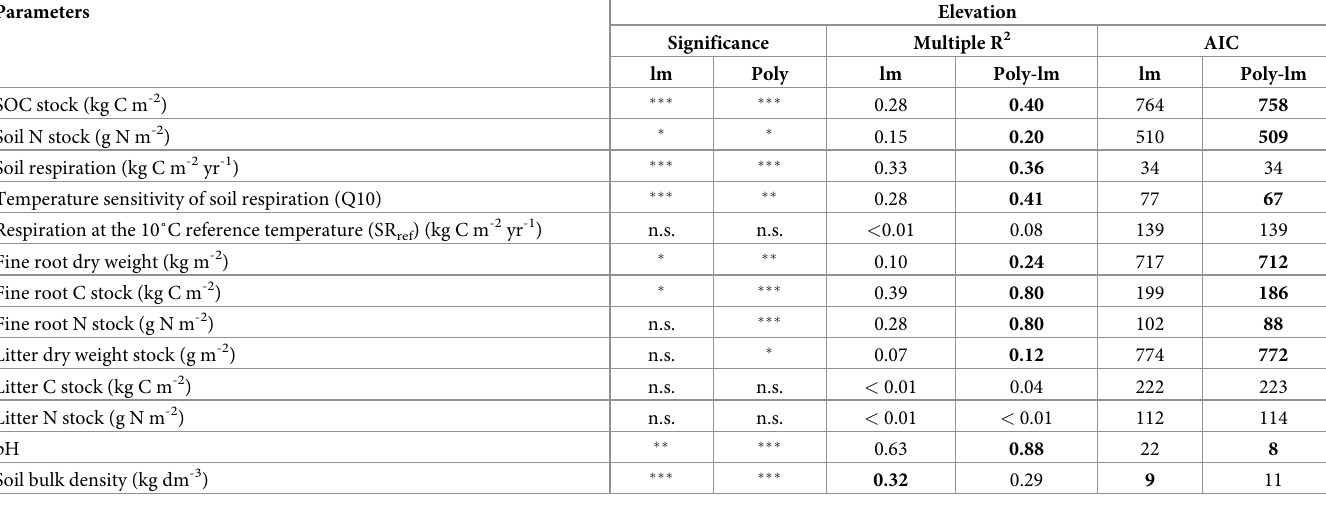
(Fig 2I): the lowest soil pH was measured in site B (pH 3.8 ± 0.1) and the highest in site E (pH 5.9 ± 0.2, Fig 2I). The highest bulk density was found in site D (1.01 ± 0.27 g cm -3 , Fig 2J) and the lowest was found in site B (0.26 ± 0.16 g cm -3 ; Fig 2J). Based on the AIC and R 2 , only soil bulk density was linearly related to elevation (Table 2). On the contrary, SOC and soil N stock, fine root dry weight, fine root C and N stock, pH and litter dry weight were better fitted with nonlinear relationships with elevation (Table 2; further detail about equation parameters can be found in S5 File). Furthermore, a significant correla- tion was found between SOC and soil N and soil pH, dominant tree height, stand age, basal area, and bulk density (Table 3). Soil respiration Both logistic and Q10 models confirmed that soil respiration rates increased with temperature in all sites (Fig 3), and the seasonal pattern of SR was similar to that of air chamber tempera- ture (S6 File). A strong linear relationship was found between observed and predicted SR (R 2 = 0.73; S7 File). Temperature explained between 55% and 76% of the variance in soil respiration at the experimental sites (Table 4). The Q10 and SR values obtained for the different sites ranged ref between 1.75 and 2.96, and between 2.17 and 4.49 ( μ mol CO m –2 s –1 ), respectively (Table 4). 2 The Q10 value recorded in site A (highest elevation) was significantly different from that of the other sites (Table 4). A significant linear relationship was identified between Q10 and ele- vation (Table 2). However, the trend between Q10 and temperature was best described by a nonlinear relationship (Table 2). Furthermore, a significant negative correlation was found between Q10 and mean dominant tree height and basal area (Table 3). No significant relation- ship between SR and elevation was found (Table 2). However, significant differences were ref found between experimental sites; the highest SR value was recorded in site B and the lowest ref values in sites A, C, and E (Table 4). Table 2. Linear (lm) and polynomial regressions (poly) between the different parameters tested and elevation. Parameters